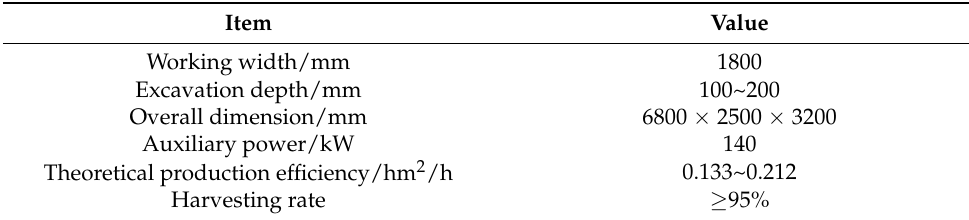
Table 1. Parameter table of